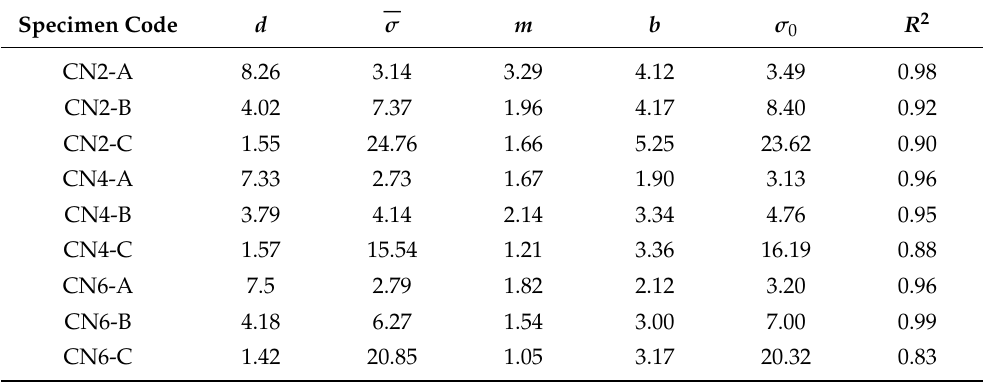
Table 3. Weibull distribution fitting